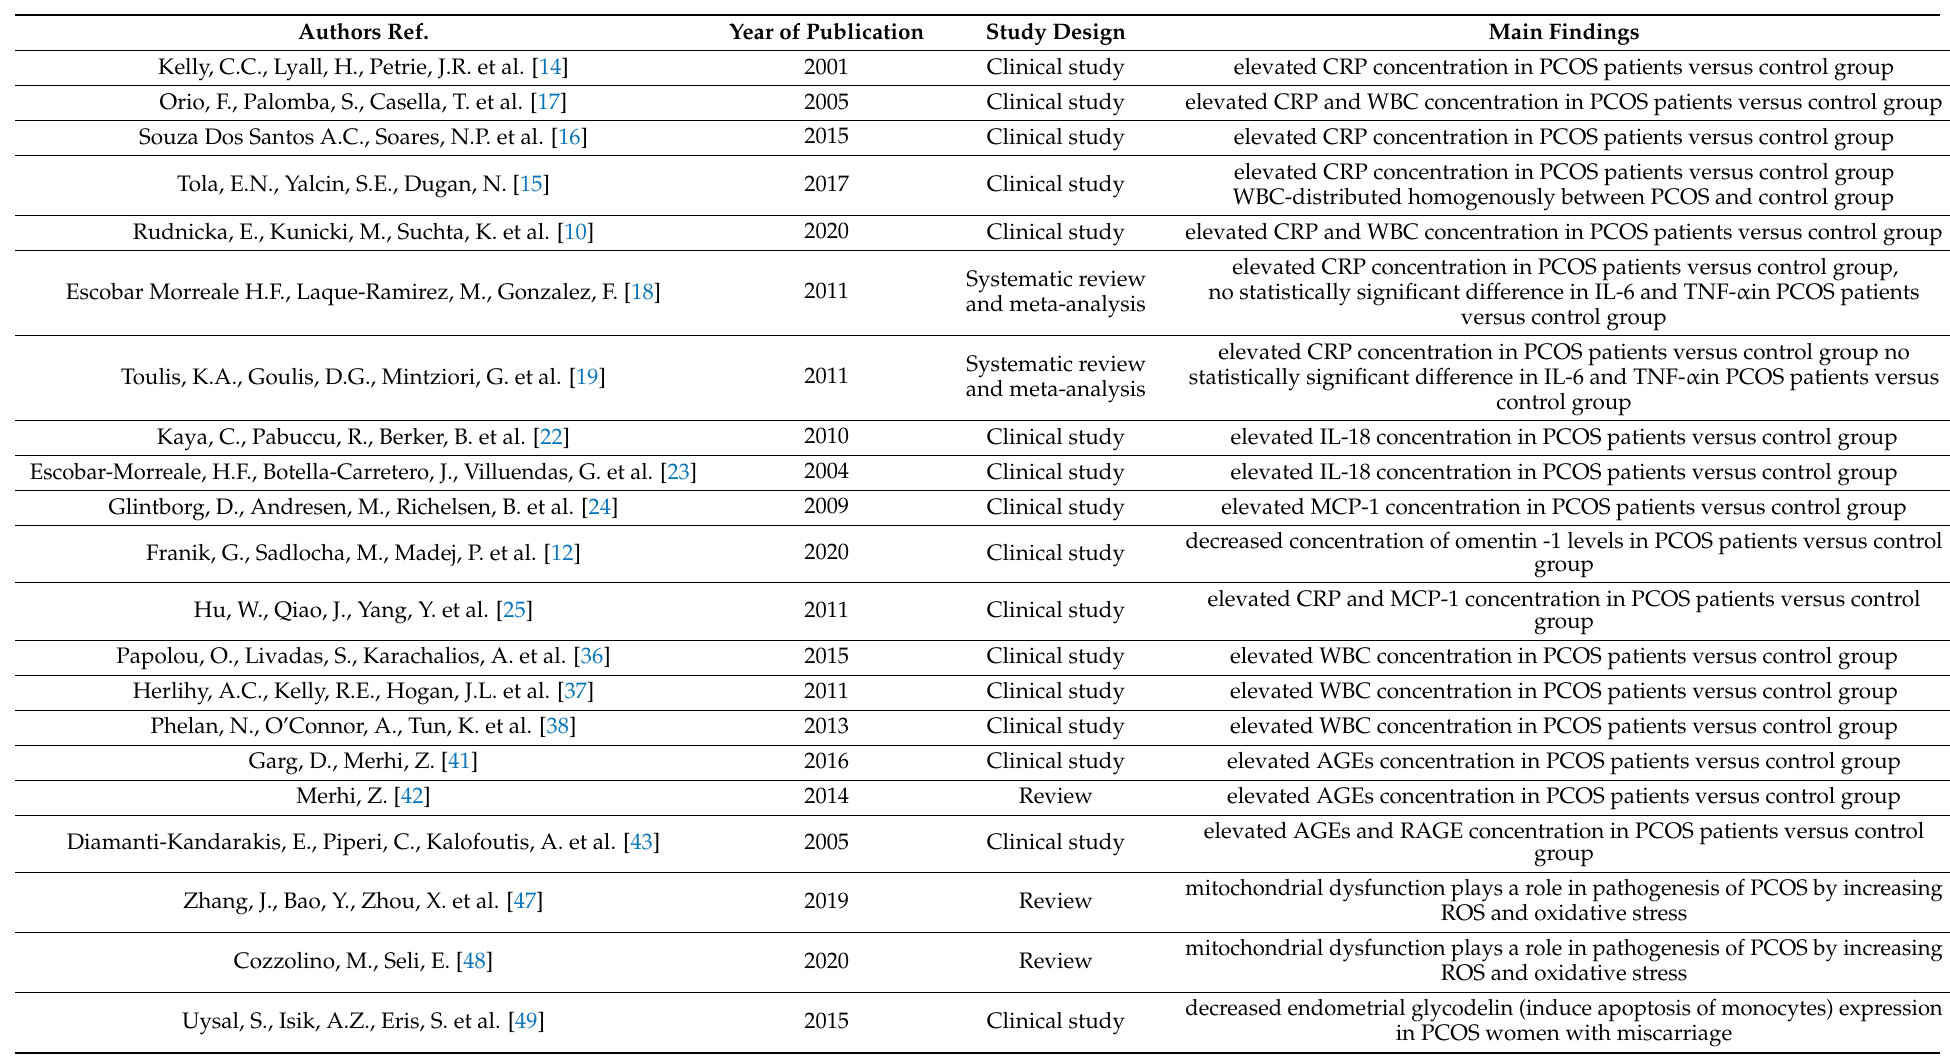
Table 1. Inflammatory markers in polycystic ovary syndrome (PCOS)